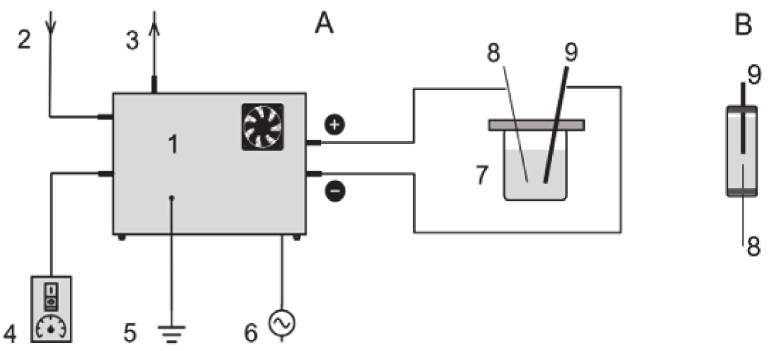
Figure 1. Schematic representation of the plasma generator connected to the Pyrex glass (PG) reactor ( A ): (1) plasma generator, (2) air inlet, (3) air outlet, (4) plasma switch and frequency control, (5) ground, (6) 220 V power supply, (7) PG reactor, (8) sintered tungsten electrode, (9) stainless steel electrode. polypropylene (PP) reactor ( B